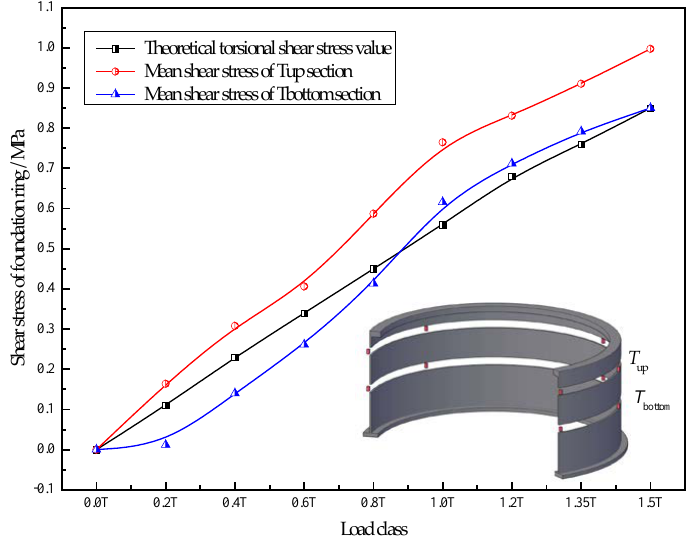
Figure 10. Torsional shear stress on the foundation ring of ZT-2.